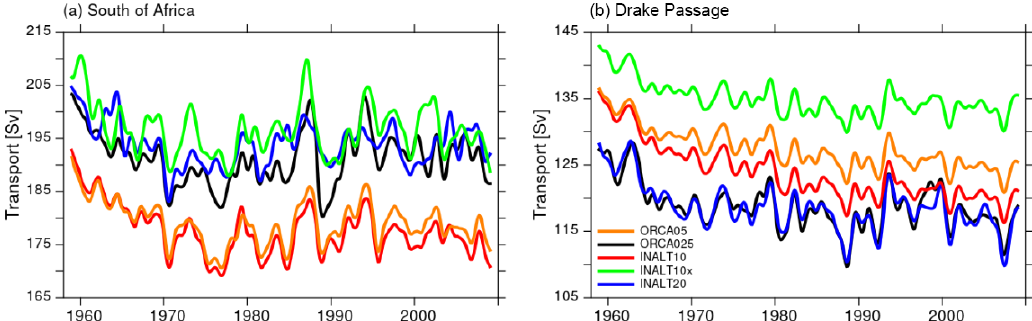
Figure 7. Time series of ACC transport (in Sv) as given by the maximum in the barotropic stream function south of Africa between 20 and 30 ◦ E (a) and the barotropic transport through the Drake Passage (b) for ORCA025 (black), INALT20 (blue), ORCA05 (orange), INALT10 (red) and INALT10x (green).